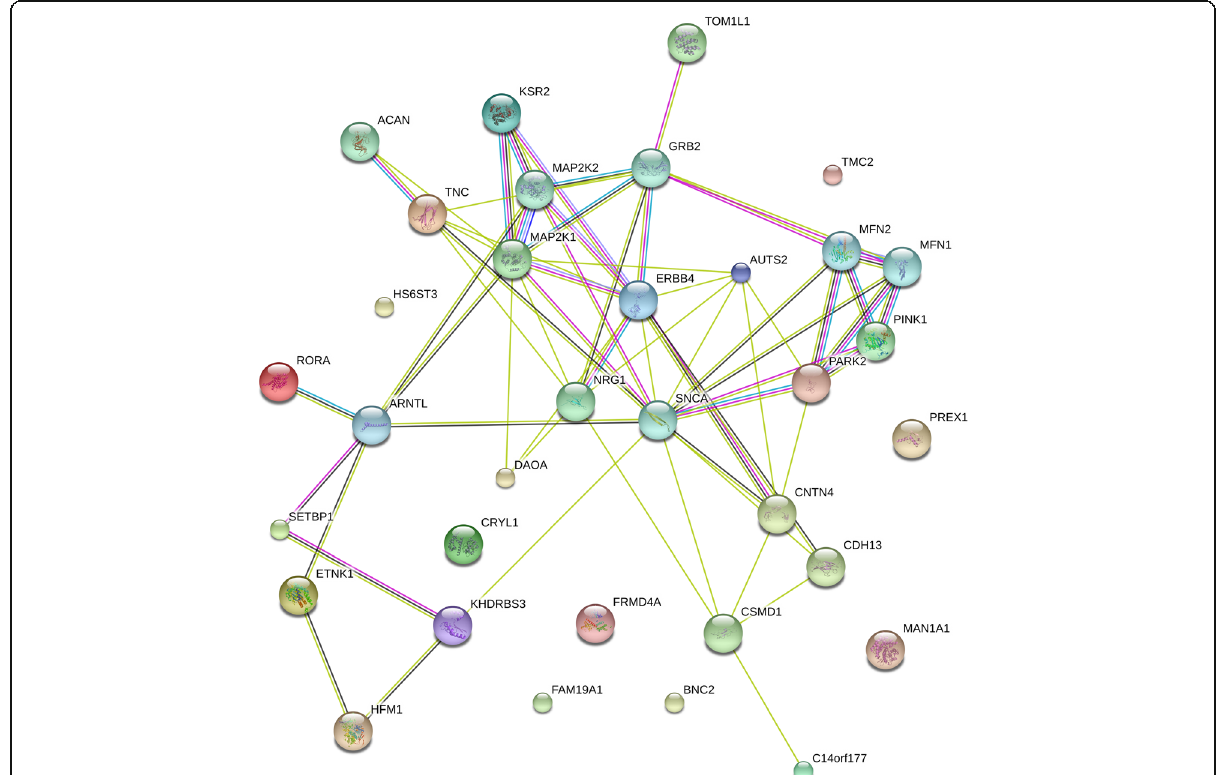
Fig. 2 Genetic Interaction network. A network of 26 identified genes annotated to risk loci with added predicted genes in interaction. All nodes represent first order interaction. Colored edges convey status of predicted network edge correspondingly cyan, curated database; magenta, experimentally determined; forest green, gene neighborhood; red, gene fusion; navy blue, gene co-occurrence; lawn green, text mining; black, co-expression; lavender indigo, protein homology. Node color signifies protein functionality. Additional nodes are considered based on prediction score ≥ 0.9 (for more details, refer to STRING data base)